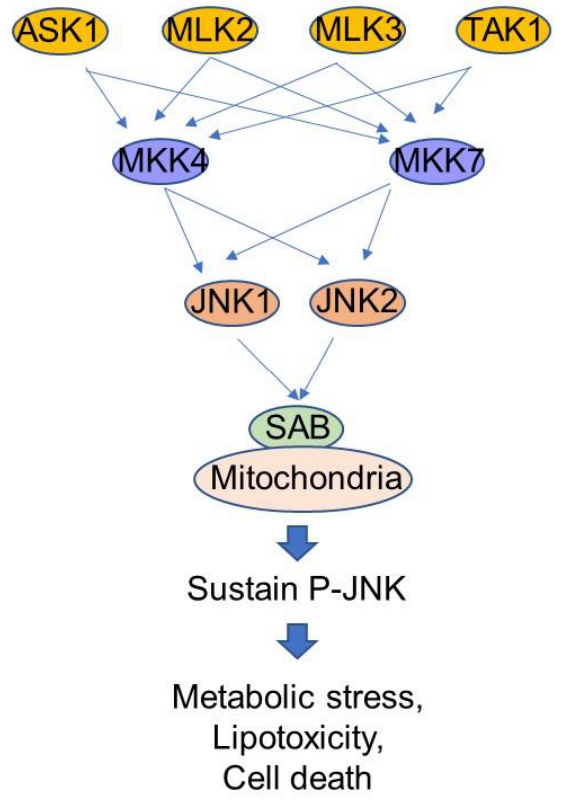
Figure 2. Stress response kinase cascade. MAP3K such as ASK1, MLK2/3, TAK1 are upstream kinases which are activated by reactive oxygen species, membrane lipid composition and changes. MKK4 and MKK7 are abundant MAP2K in liver. JNK1 and JNK2 are MAP kinases with functional redundancy in liver. SAB is a mitochondrial outer membrane protein and directly interacts with P-JNK, but not interact with p38 in vivo. Suppression of SAB expression or inhibition of P-JNK-SAB interaction is a plausible therapeutic target of hepatic metabolic stress in NASH.